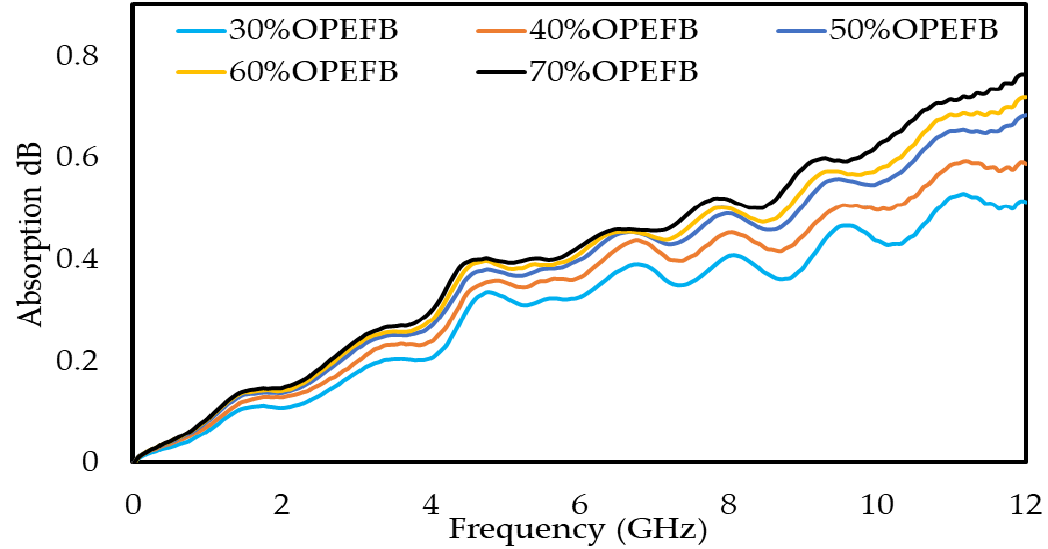
Figure 13. Calculated absorption loss of different compositions of OPEFB/PLA composites at various percentages of OPEFB filler.